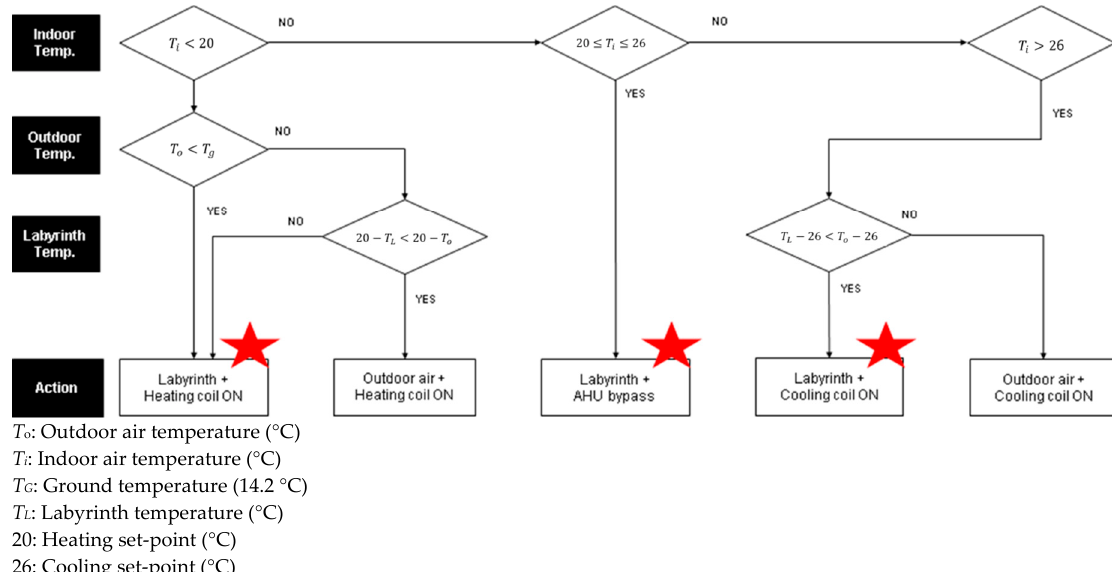
Figure 11. Thermal labyrinth system operational algorithm.